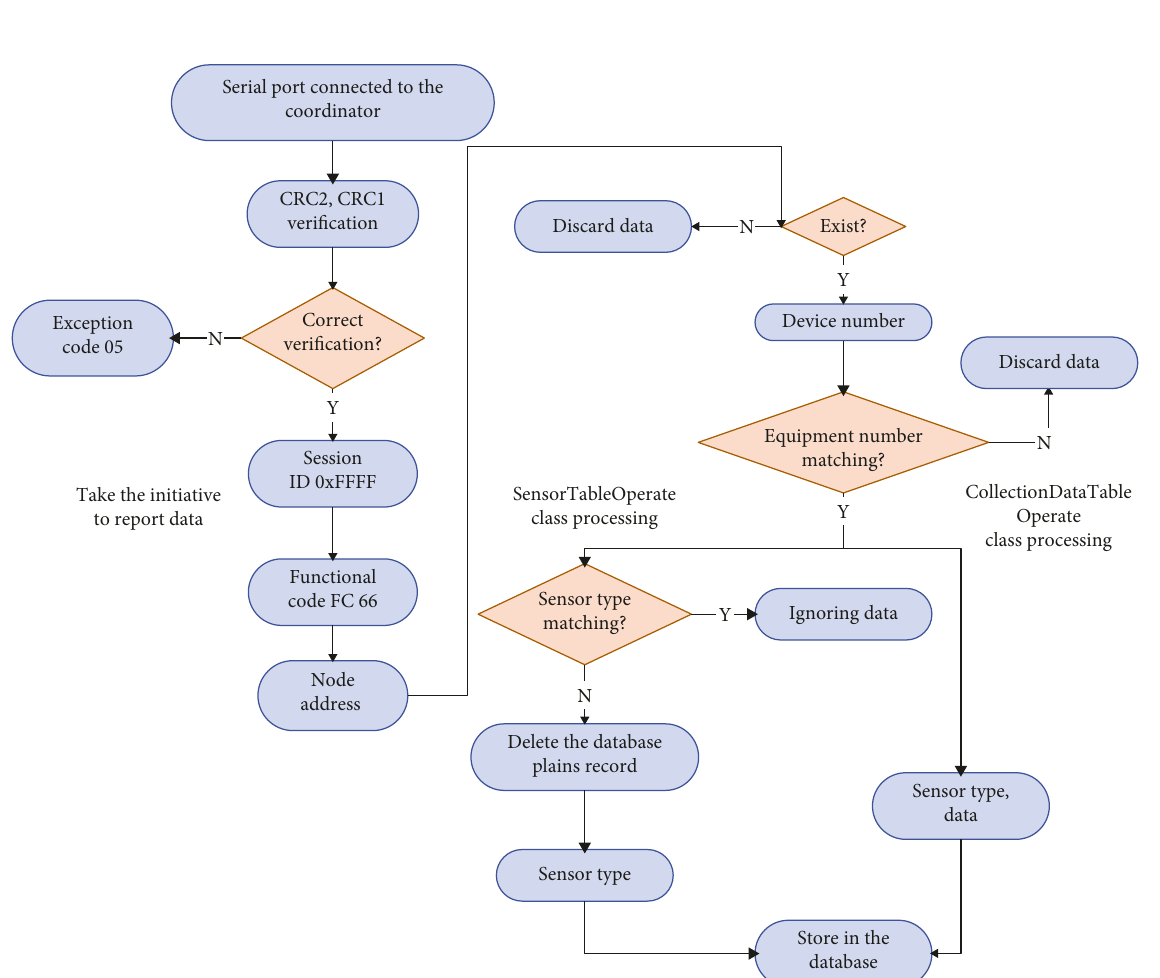
Figure 9: The flowchart of the terminal processing the actively reported